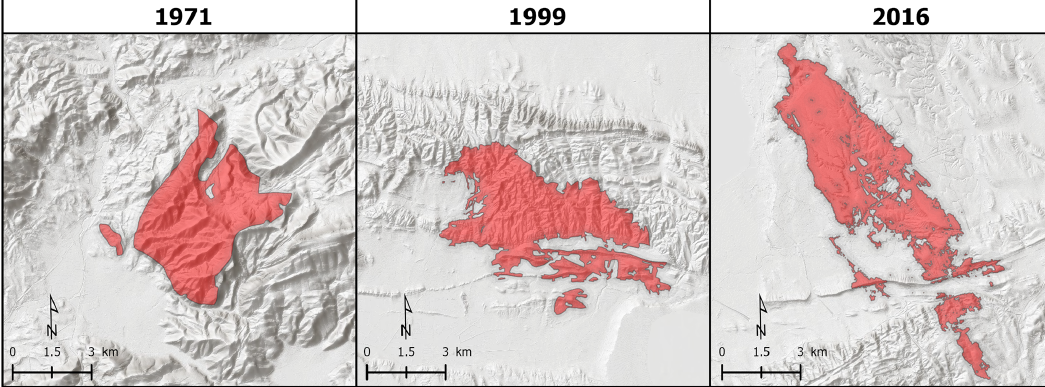
Figure 2. Evolution of digitized burn scar accuracy over the past few decades.